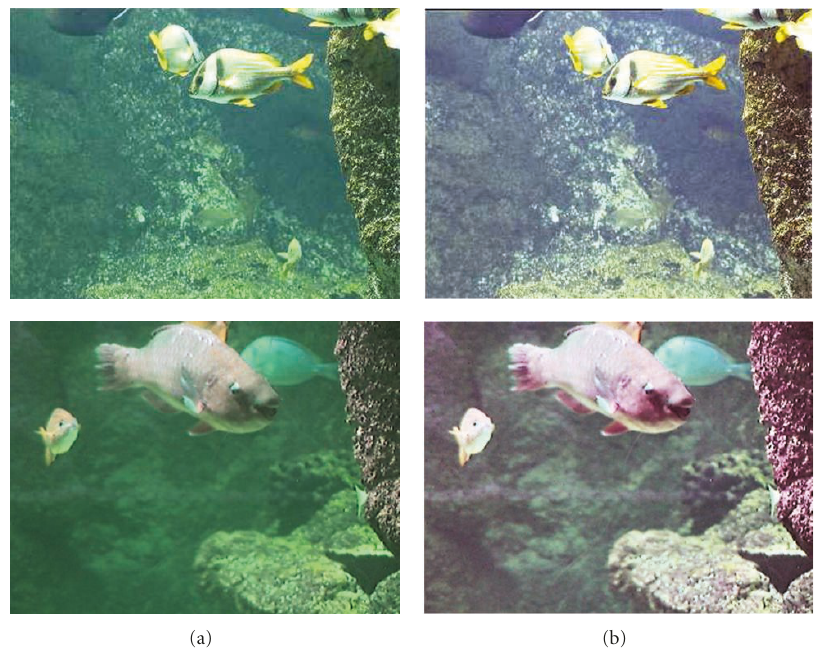
Figure 7: Original images (a), after correction with ACE (b). Image courtesy of Chambah et al. [23].